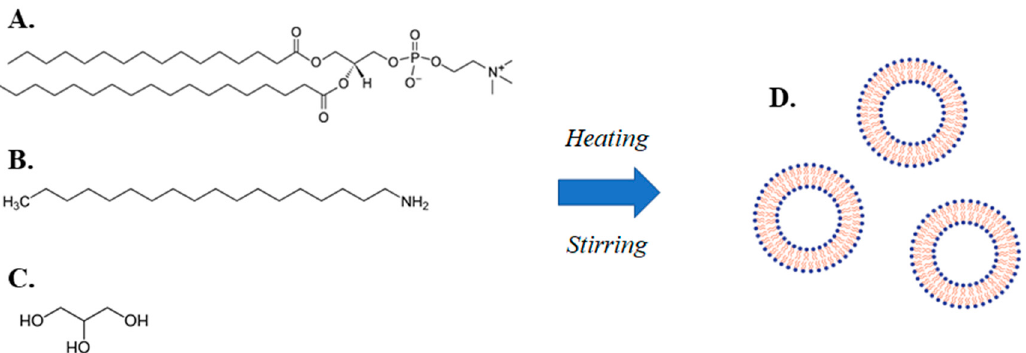
Figure 1. Illustration of the modified heating method (MHM) for lipidic vehicle preparation, including an aqueous mixture of ( A ) a phospholipid (e.g., L- α -phosphatidylcholine, hydrogenated (Soy) (HSPC)), ( B ) a charged lipid or a fluidity regulator (e.g., stearylamine), ( C ) a liquid polyol (e.g., glycerine), which through the application of a two-step heating process accompanied by stirring, leads to the production of ( D ) lipidic vehicles (e.g., liposomes).